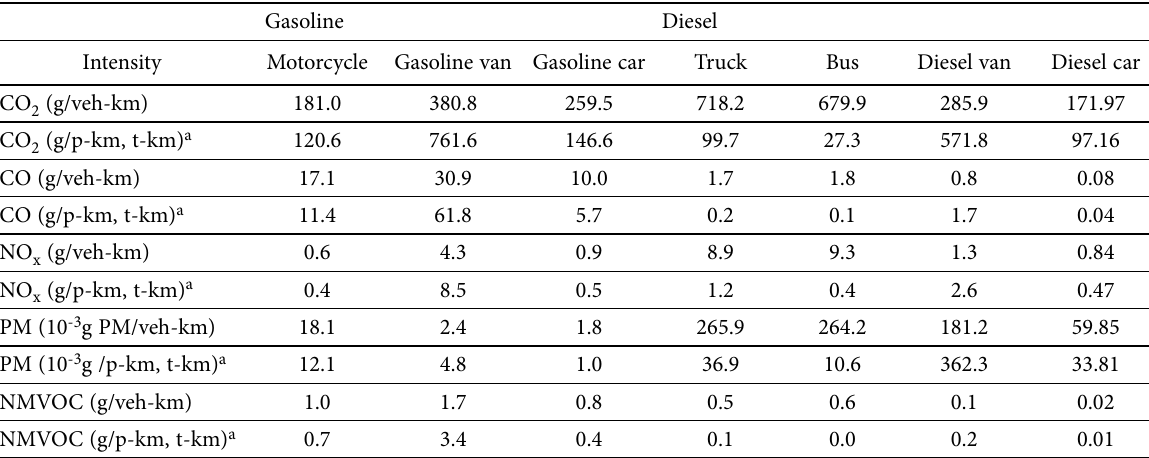
Fig. 5. Vehicle fleet in Spain by fuel type and emission standards (situation at 31/12/2009) Table 3. CO 2 and pollutant intensities estimated for gasoline and diesel technologies by vehicle types in Spain, average values for 2004–2009 (source: this